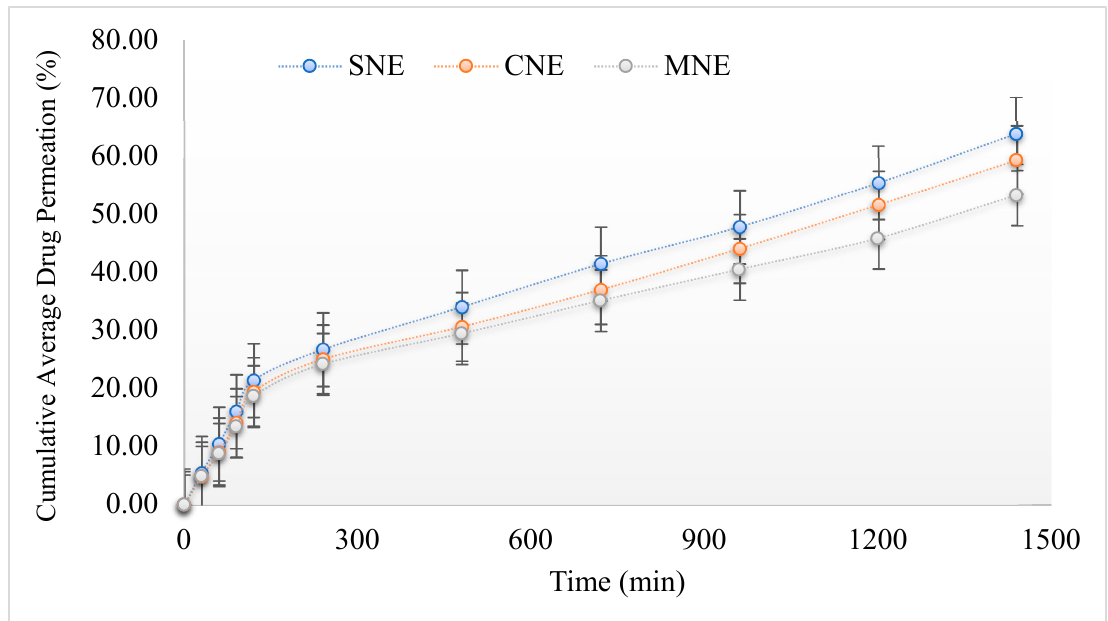
Figure 5. Permeation profiles of formulated nanoemulsions. Data were expressed as mean ± SD, n = 3.